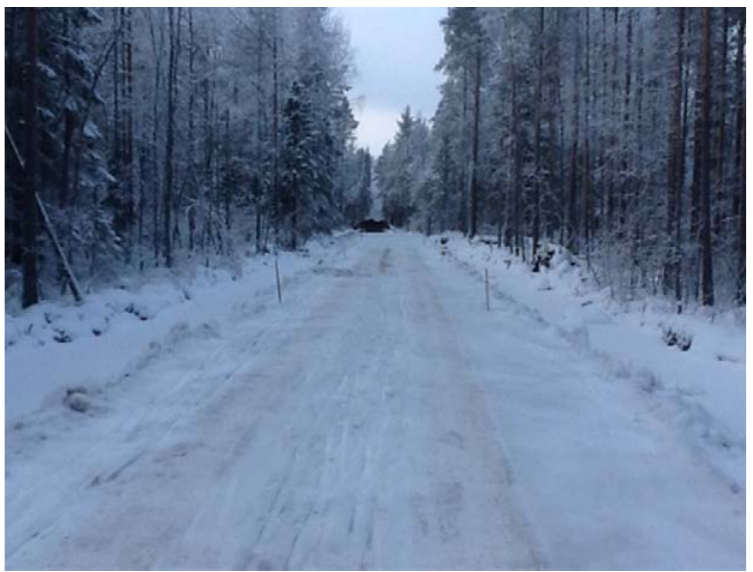
Figure 1. Northwest area of the Russian Federation. Winter forest road in the Republic of Karelia (photo by V.K.).